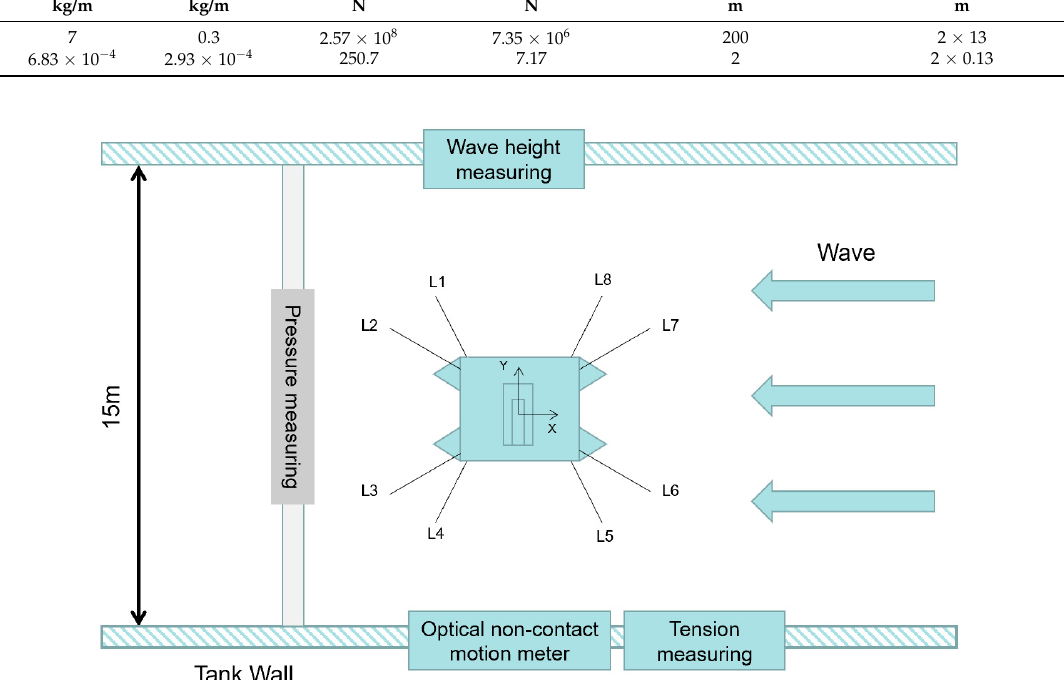
Figure 6. Top-view diagram of the test model after installation.